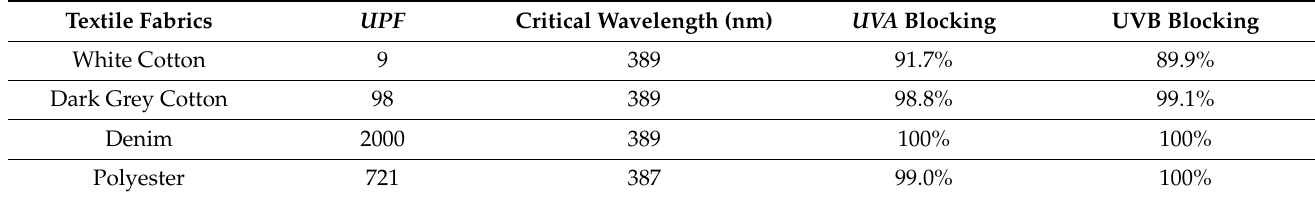
Table 3. UV-protective measurements of textiles from the literature [66]